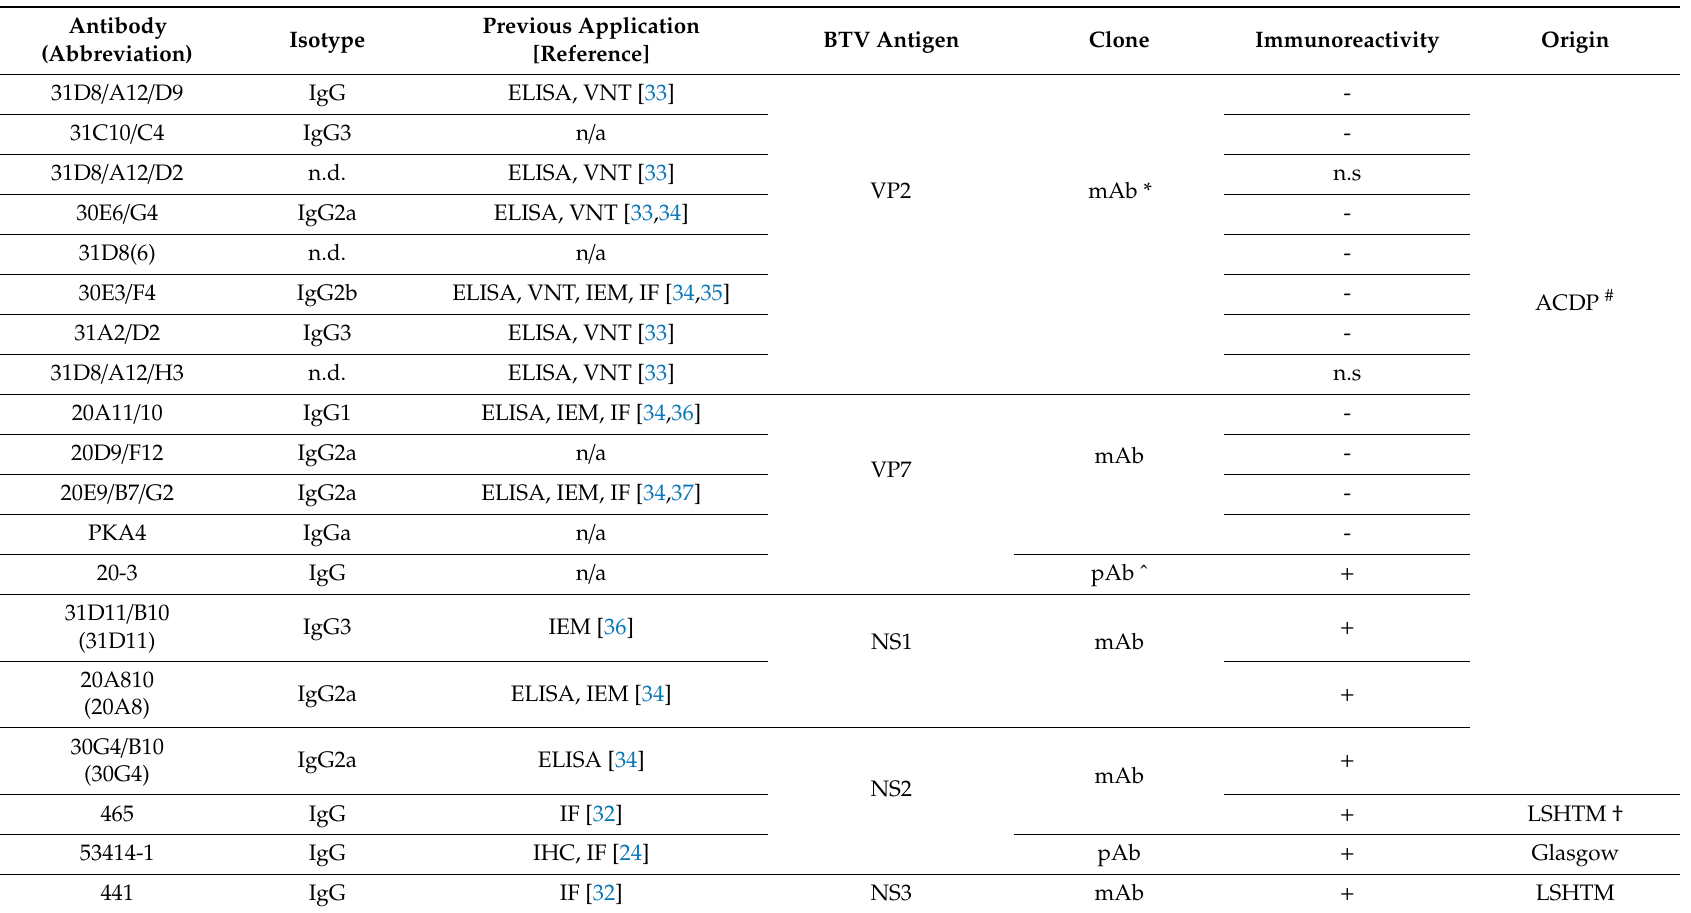
Table 1. List of antibodies screened for immunoreactivity to bluetongue virus (BTV)-1-infected formalin-fixed para ffi n-embedded cell pellet by